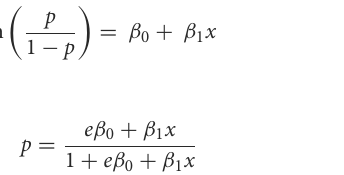
represents zero (0). The second part of the questionnaire captured data on COVID-19 vaccination acceptability and perceptions formulated based on the literature (18). Also, the authors processed other data into categorical, ordinal, and continuous variables.